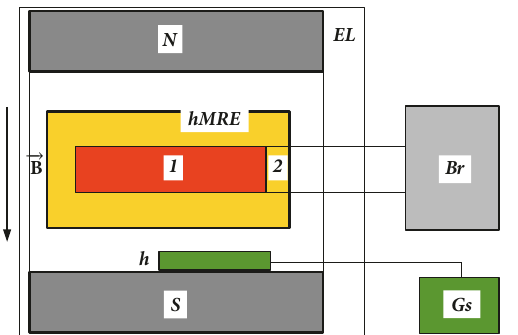
Figure 5: Experimental setup (overall configuration): EL, electro- magnet; N and S, magnetic poles; hMRE, measuring cell; 1 and 2, MRE body based on SR and, respectively, MRS; Br, RLC bridge; Gs, Gaussmeter; h, hall probe; 𝐵 , magnetic flux density vector.